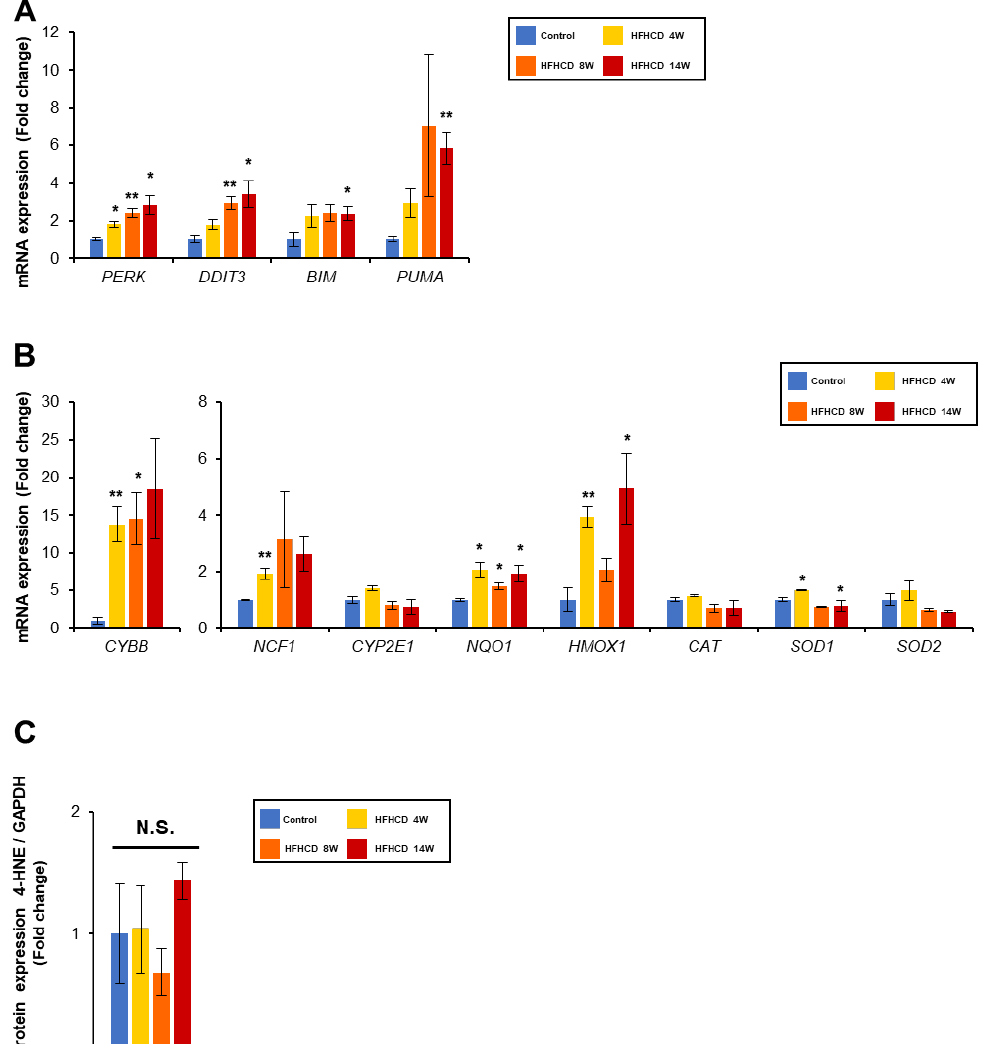
Figure 6. HFHCD induced ER stress and related apoptosis genes, but did not affect oxidative stress. ( A , B ) Hepatic mRNA levels of genes related to ER stress ( A ), oxidative stress production and elimination ( B ) were quantified via real-time PCR and normalized to GAPDH. ( C ) Hepatic protein levels of 4-HNE were determined using immunoblot analysis. The band intensity was normalized to that of GAPDH and expressed as a relative value compared with control rabbits. The full-length blots are shown in Supplementary Figure S1. Data are shown as the mean ± SEM. * p < 0.05, ** p < 0.01 vs. control group. N.S., not significant. Control group (12 weeks, n = 3), HFHCD group; 4 weeks (n = 3), 8 weeks (n = 4), 14 weeks (n = 4).